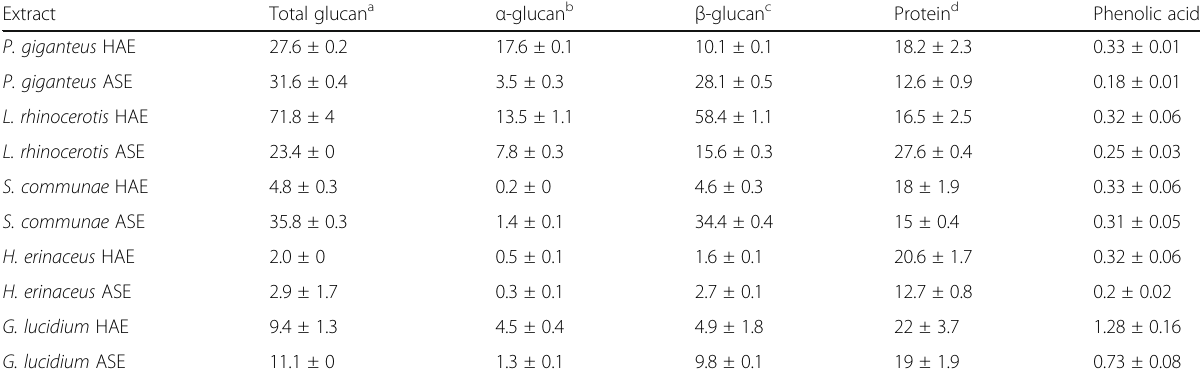
Table 5 The percentage of total glucan, α -glucan, β -glucan, protein and phenolic acid content in mushroom HAEs and ASEs Extract Total glucan